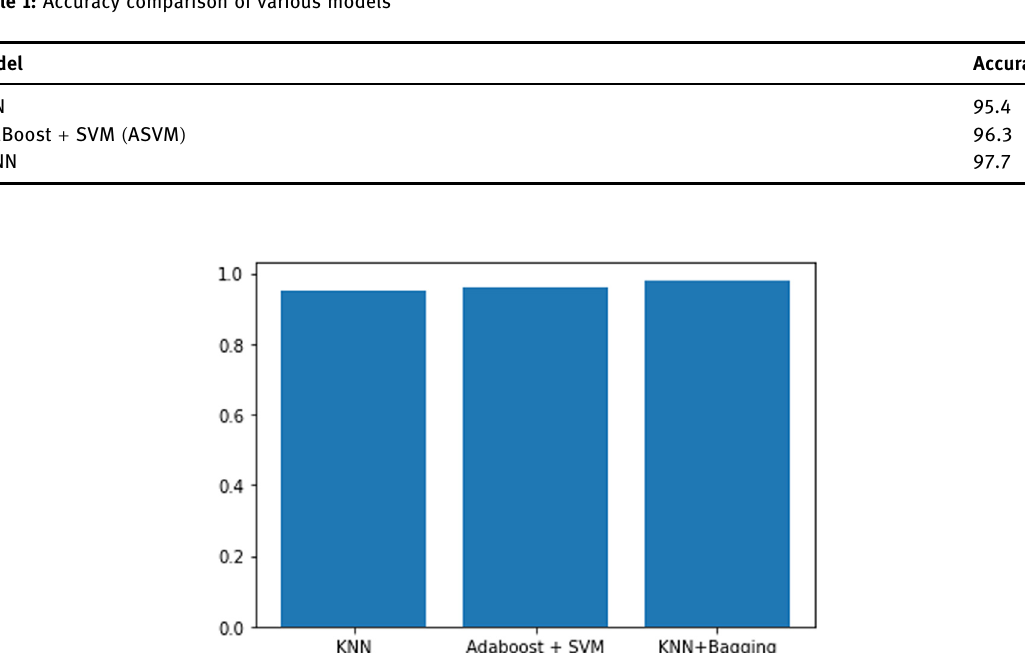
Table 1: Accuracy comparison of various models